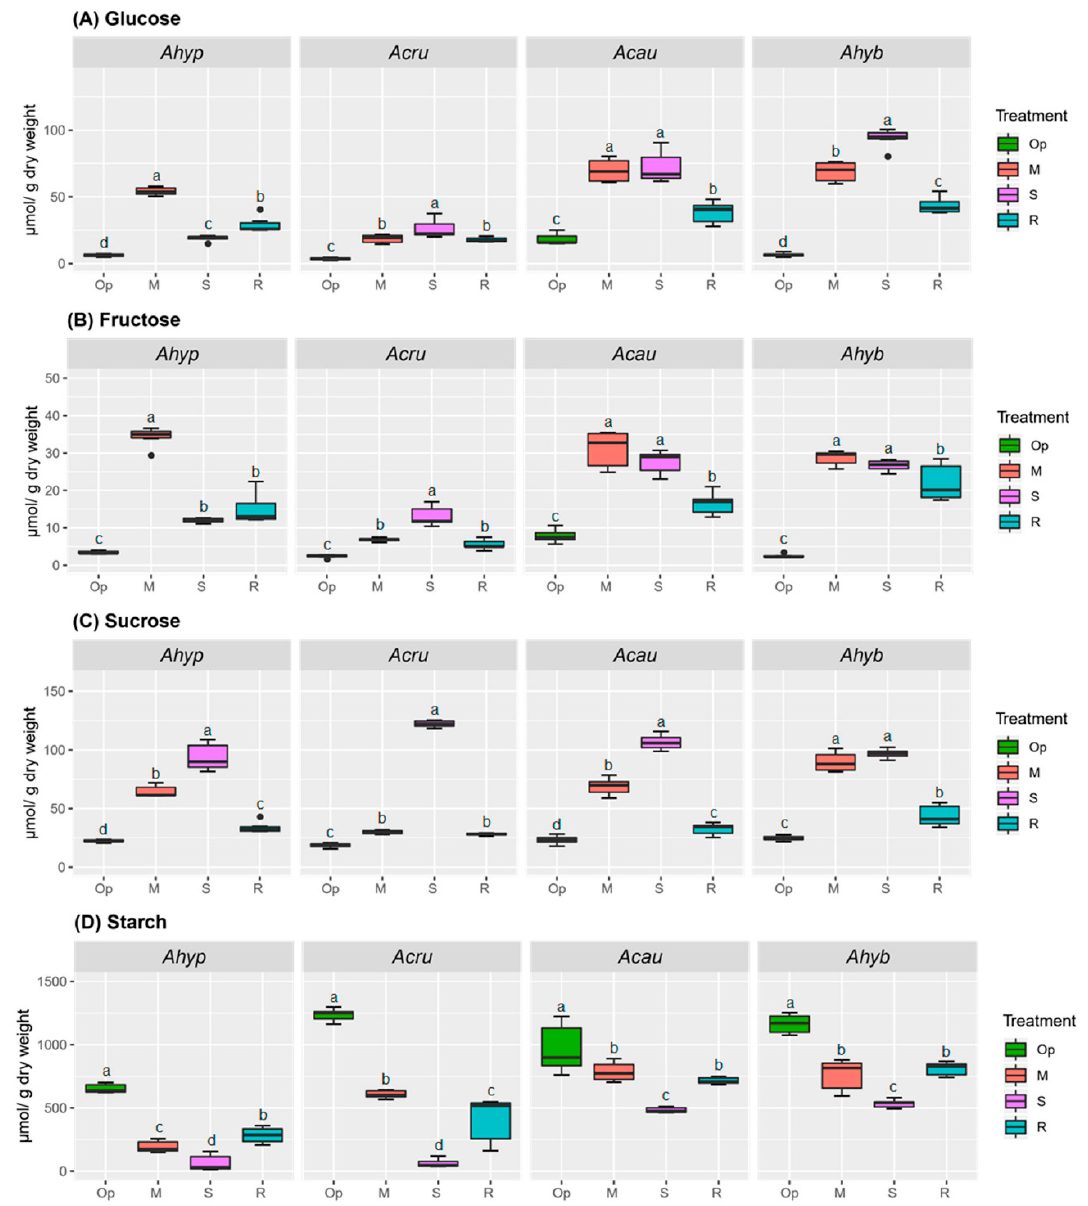
Figure 1. Non-structural carbohydrates in leaves of amaranth plants subjected to water-deficit stress. ( A ) Glucose, ( B ) fructose, ( C ) sucrose and ( D ) starch content in leaves of Amaranthus hypochondriacus (Ahypo), A. cruentus (Acru), A. caudatus (Acau) and A. hybridus (Ahyb) plants growing in optimal conditions (Op), subjected to moderate (M) or severe (S) water-deficit stress, or allowed to recover from S, 1 day after normal watering was restored (R). Different letters over the box-and-whisker plots represent statistically significant differences at p ≤ 0.05 (Tukey Kramer test; n = 9). Box-and-whisker plots show high, low, and median values. The results shown are those obtained from a representative experiment that was repeated in the spring-summer and summer-autumn seasons of 2015, respectively, with similar results.